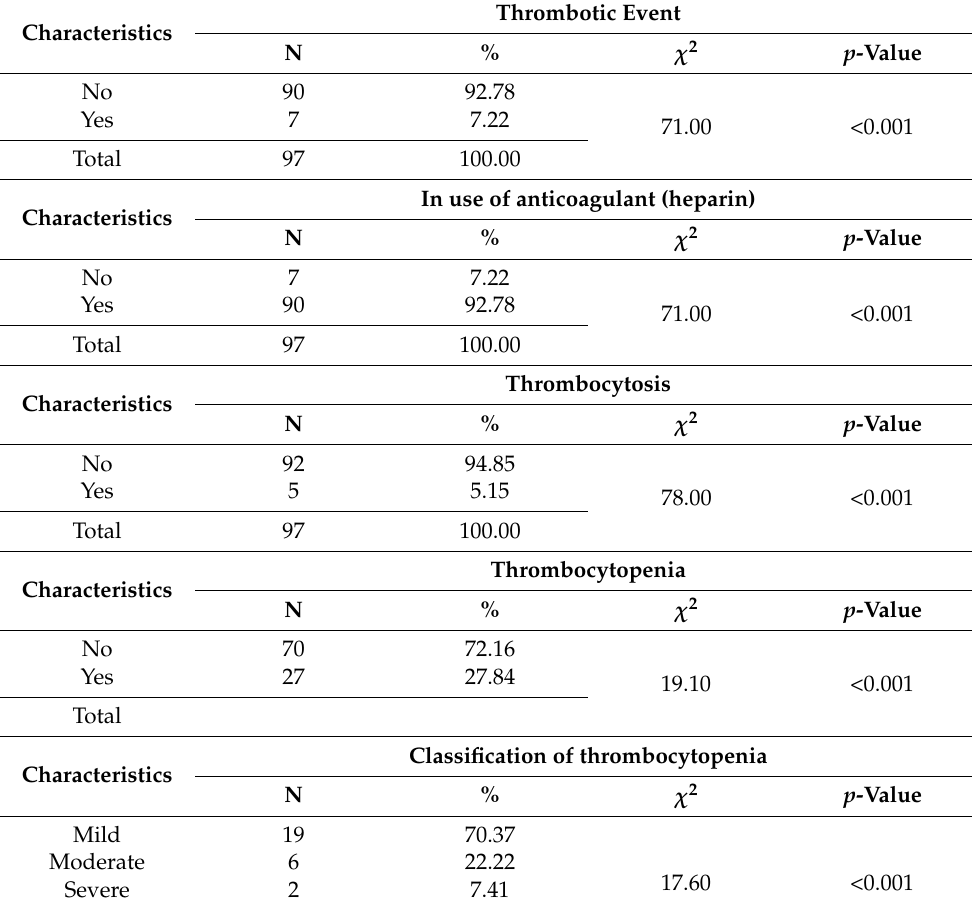
Table 4. Description of frequencies for thrombotic events, use of anticoagulants, thrombocytosis, thrombocytopenia, and classification of thrombocytopenia in hospitalized patients with clinical suspicion of COVID-19 in a hospital in the Tri â ngulo Mineiro region, Brazil. Characteristics